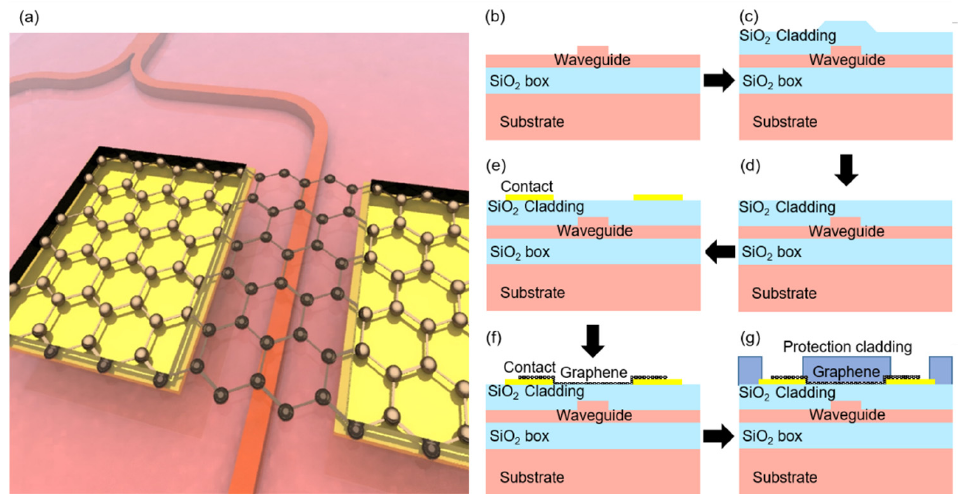
Figure 1. ( a ) Three-dimensional illustration of the MZI-based TO switch with the graphene heater. ( b – g ) Brief process flow of the TO switch with graphene heaters. ( b ) Waveguide fabrication. ( c ) SiO 2 deposition as a cladding layer. ( d ) Chemical-mechanical planarization of the cladding. ( e ) Electrode contact fabrication. ( f ) Graphene transfer and patterning. ( g ) Protection cladding coating with electrode contact windows